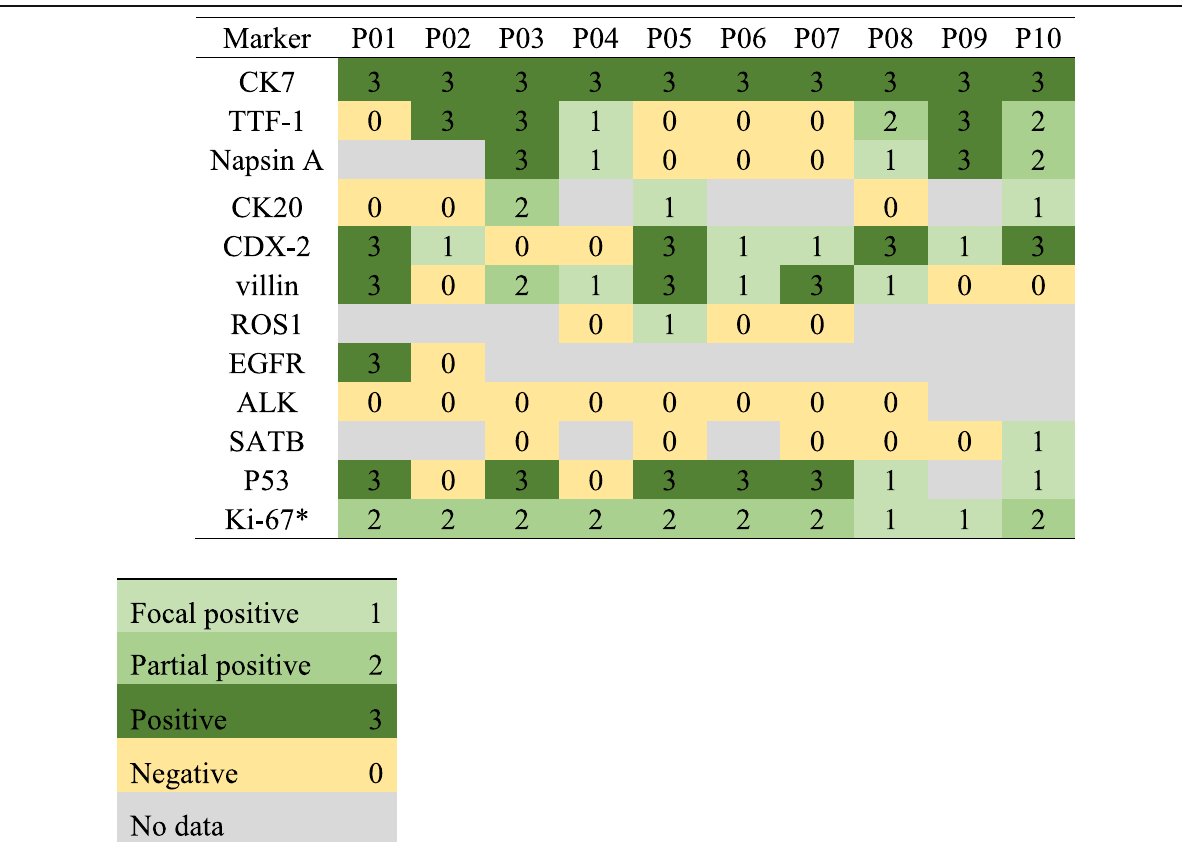
Table 2 Immunohistochemical features in the patients with